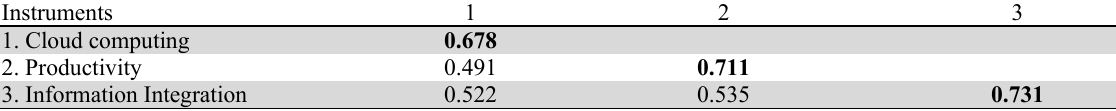
Divergent validity based on Fornell–Larcker approach Instruments